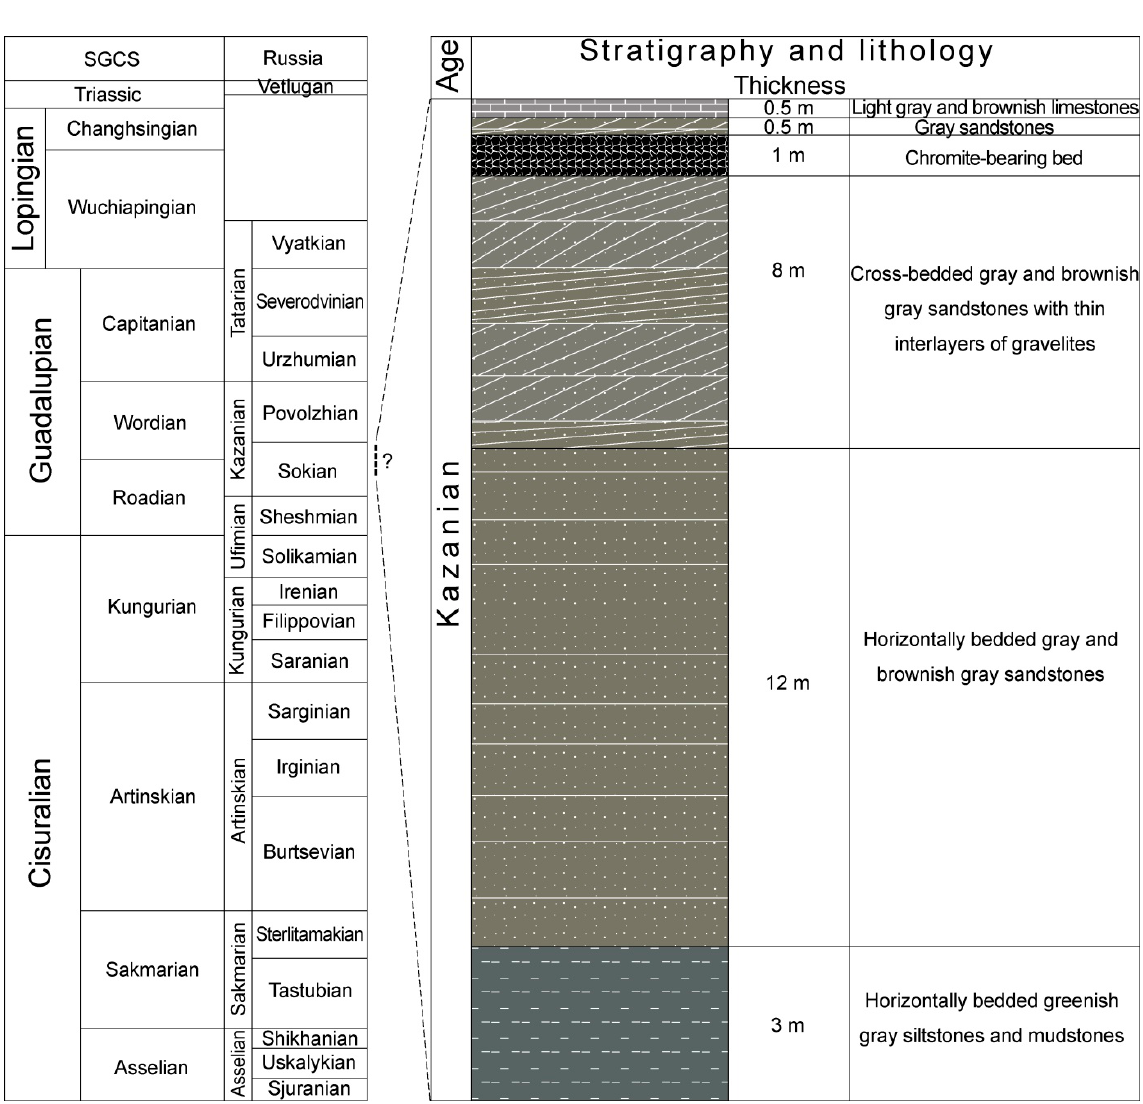
Figure 2. Stratigraphic and lithological chart of the Sabantuy paleoplacer cross-section ( right ) with a comparison to the Standard Global Chronostratigraphic Scale (SGCS) and the General Stratigraphic Scale of Russia [39] ( left ).